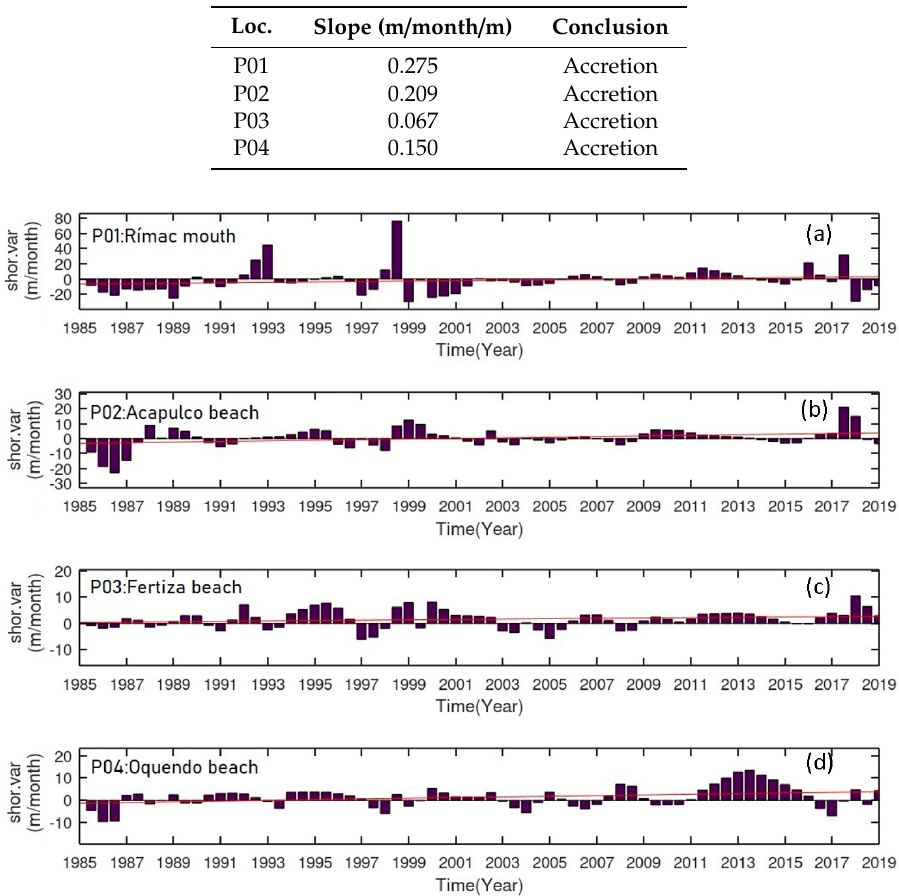
Table 4. Linear regression coefficients in control points.